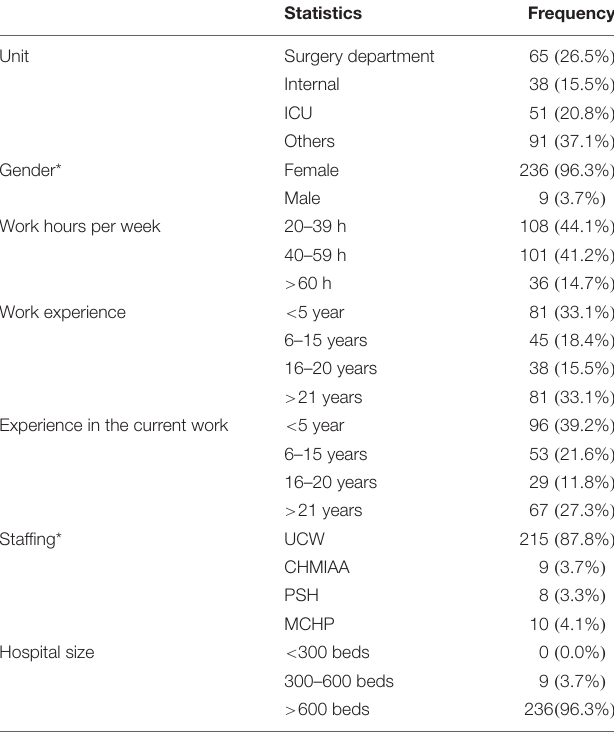
TABLE 1 | Socio-demographic and work characteristics of nurses in the study ( N =